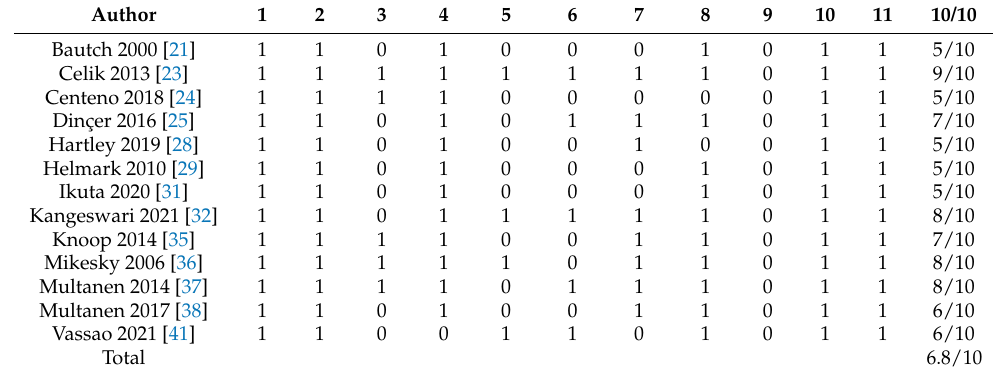
Table 3. PEDro scale for the risk of bias and quality of the studies assessment for the randomized controlled trails manuscript